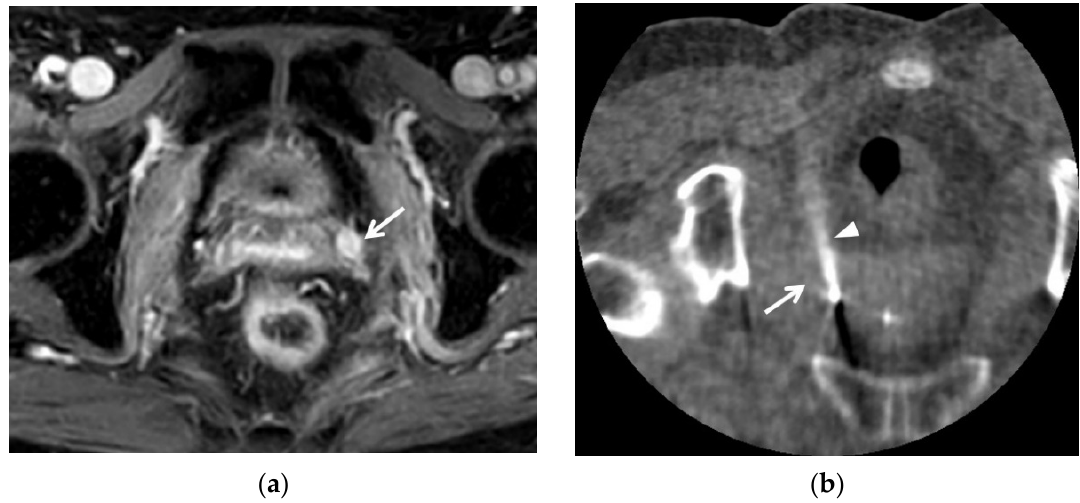
Figure 5. A 62-year-old woman with a recurrent cervical cancer: ( a ) contrast-enhanced T1-weighted axial image showed a small recurrent cancer (arrow) with strong enhancement. This patient underwent concurrent chemo-radiation therapy due to advanced cervical cancer. This tumor was detected early on this follow-up MRI. ( b ) Unenhanced CT axial image showed the recurrent tumor (arrow) in the patient who was prone on the CT table. The arrowhead indicates the radiofrequency electrode (arrowhead) targeting the recurrent cervical cancer perpendicularly. The tumor was completely ablated, and the patient remained free of recurrent tumor for 16 months after radiofrequency ablation treatment.